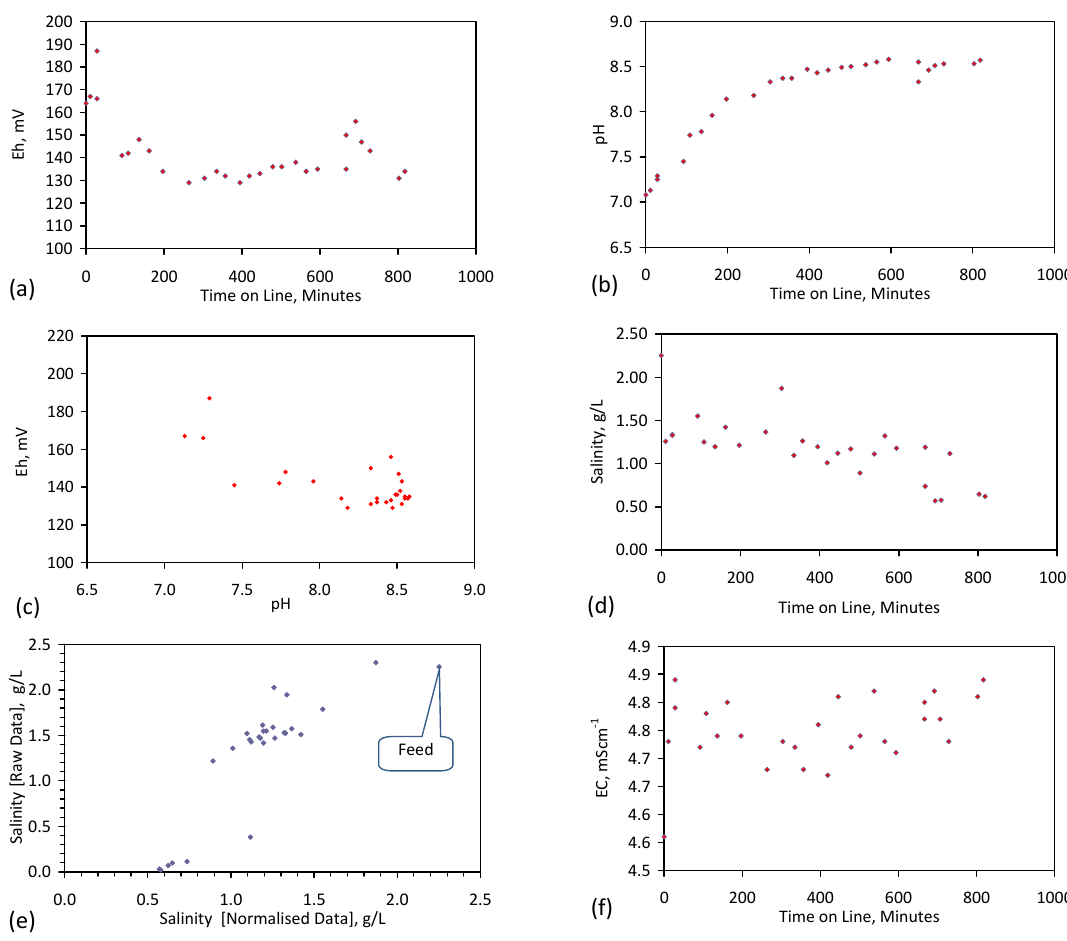
Figure C27. ZVM TPA example Trial E146. 7th Reuse; Operating Temperature: 18–22 °C; Oxidising Environment: Water volume in the reactor = 0.24 m 3 ; ZVM TPA from Trial E145 in a cartridge = 0.4 kg; Air flow = 120 L·h − 1 . ( a ) Eh vs. time; ( b ) pH vs. time; ( c ) pH vs. Eh; ( d ) Salinity vs. time; ( e ) Salinity calculated from normalised data vs. salinity calculated from raw data; ( f ) EC vs. time.